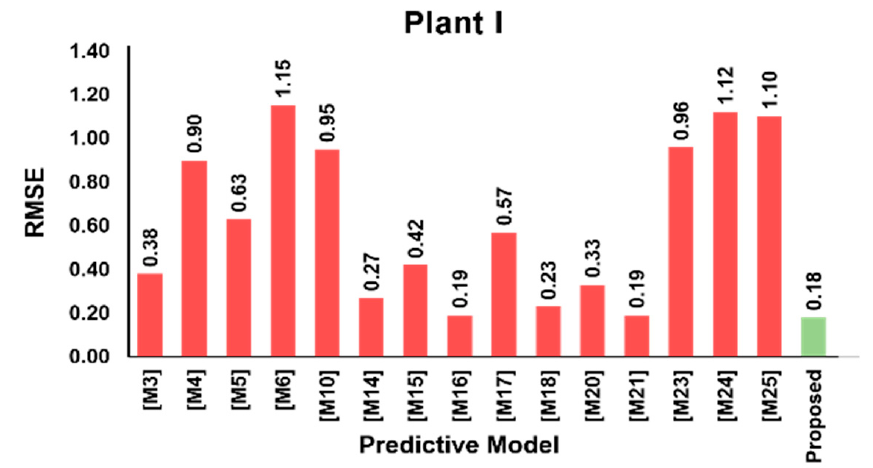
Figure 11. Comparison of root mean squared error (RMSE) values for existing and proposed models for predicting dephosphorization in steel for Plant I.